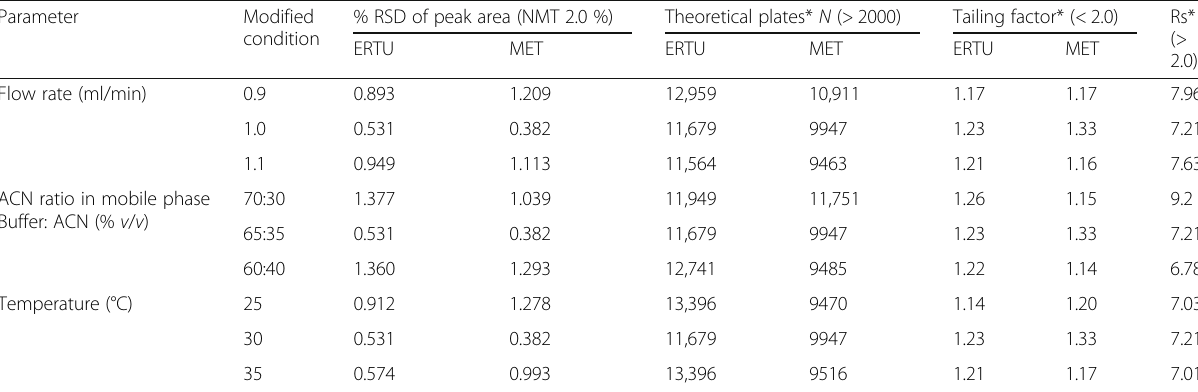
Table 6 Robustness of ERTU and MET Parameter